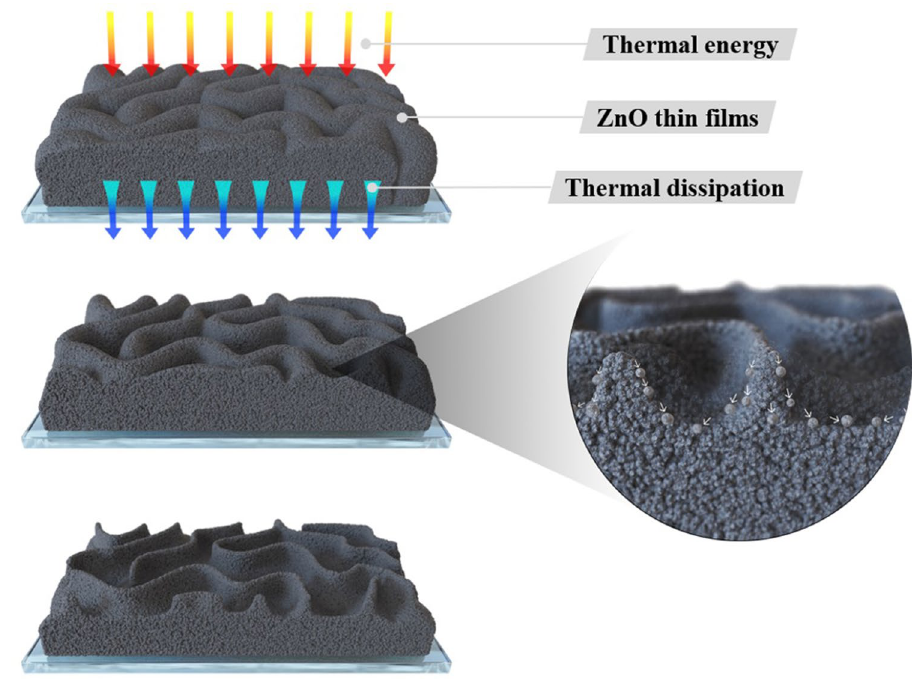
Figure 4. Schematics images of ZnO molecules movement during TDA annealing process. The schematic images were prepared by first author Dongwan